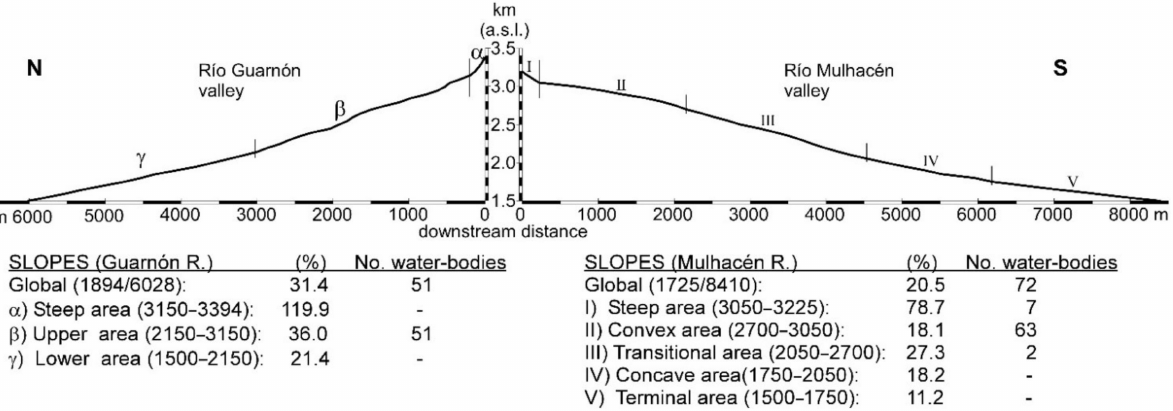
Figure 11. Geomorphological cross section along the central axes of two representative valleys: Guarn ó n River (Atlantic watershed) and Mulhac é n River (Mediterranean watershed). The table at the bottom shows the general slope of each river and its different slope stretches (Greek and Roman symbols), and the number of water-bodies in each stretch. Transect has a general N–S direction. The numbers in brackets indicate, for the global slope, the quotient between altitude/length and, for other areas, the range of altitudes at which the slope is defined. Vertical scale = horizontal